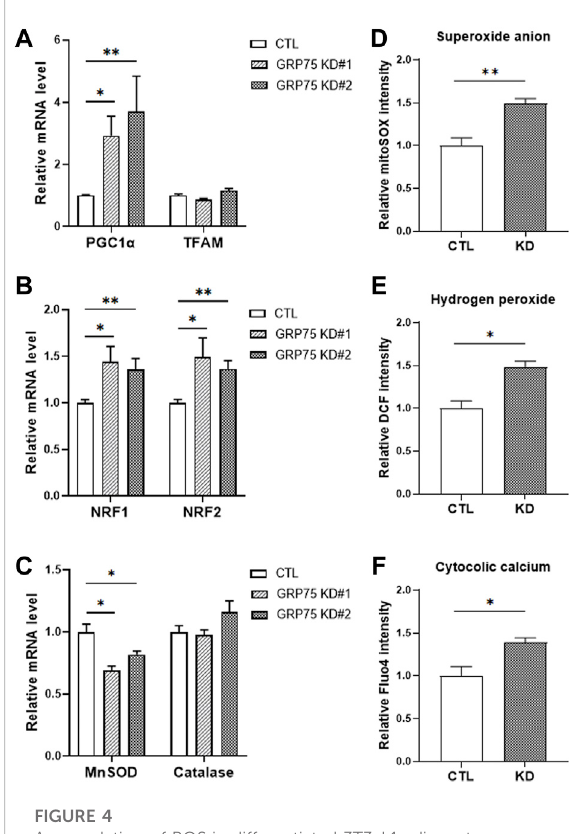
FIGURE 4 Accumulation of ROS in differentiated 3T3-L1 adipocytes with GRP75 knockdown. (A – C) The mRNA levels of mitochondrial biogenesis-related genes (PGC1 α , TFAM, NRF1 and NRF2) and antioxidant enzymes(MnSOD and catalase) were determined byRT-PCRin3T3-L1preadipocyteswithCTLKD,GRP75KD#1and GRP75 KD#2 7 days after differentiation. N = 6 in each group. (D – F) The intracellular levels of superoxide anions (D) , hydrogenperoxide (E) andcytosolicCa 2+ ions (F) weredetermined in 3T3-L1 preadipocytes with CTL KD, GRP75 KD#1 and GRP75 KD#2 7 days after differentiation using MitoSOX, DCF and Fluo-4 dyes, respectively. N = 4 in each group. Data are presented as means ± SEM; * p < 0.05; ** p <